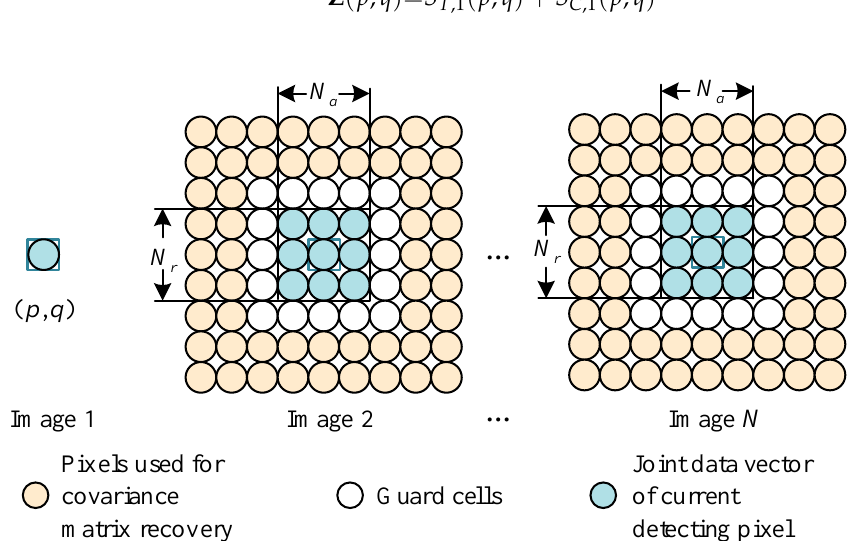
Figure 3. Formulation of joint-pixel